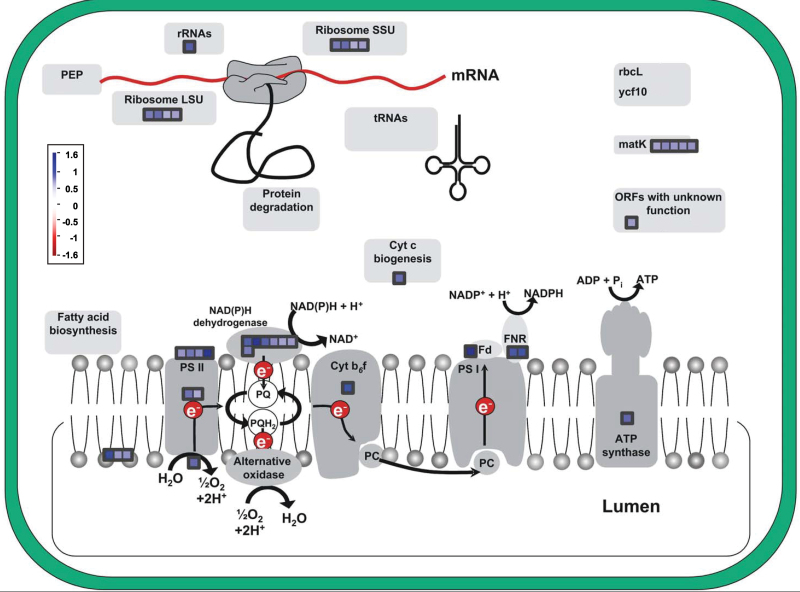
Transcripts related to photosynthesis showing change in M. × giganteus after 14 days of chilling. Colouration scale as in Fig. 1. See Table 2 for numerical details of the change in each transcript.